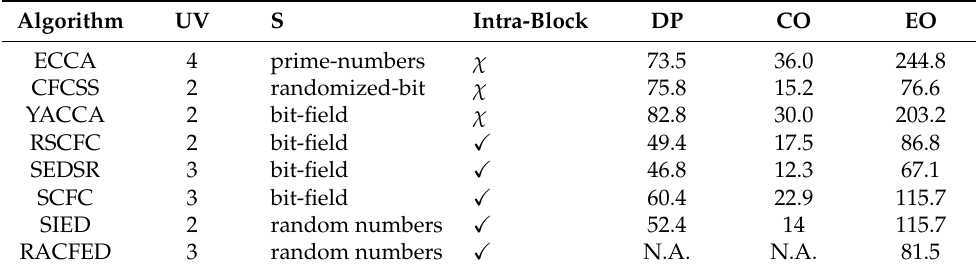
Table 1. Comparison of CFC methods. UV indicates used variables, S indicates signatures, DP indicates detection performance [%], CO indicates code size overhead [%], and EO indicates execution time overhead